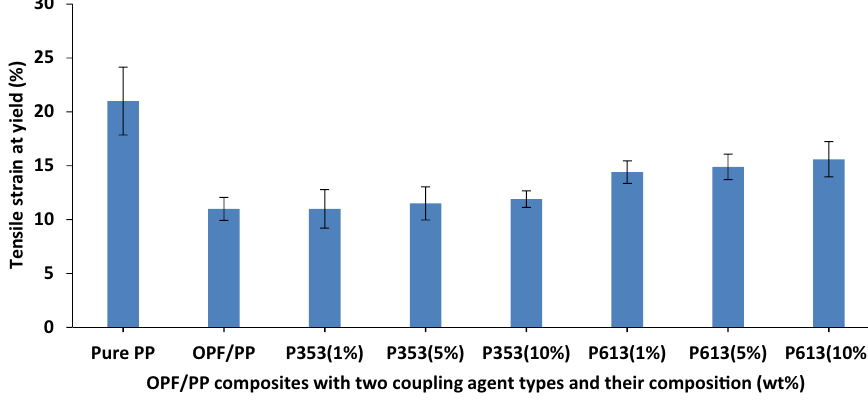
Figure 4: Tensile strain at yield of the pure PP, uncoupled, and coupled 20% OPF/PP polymer composite with two coupling agent types of di ff erent weight